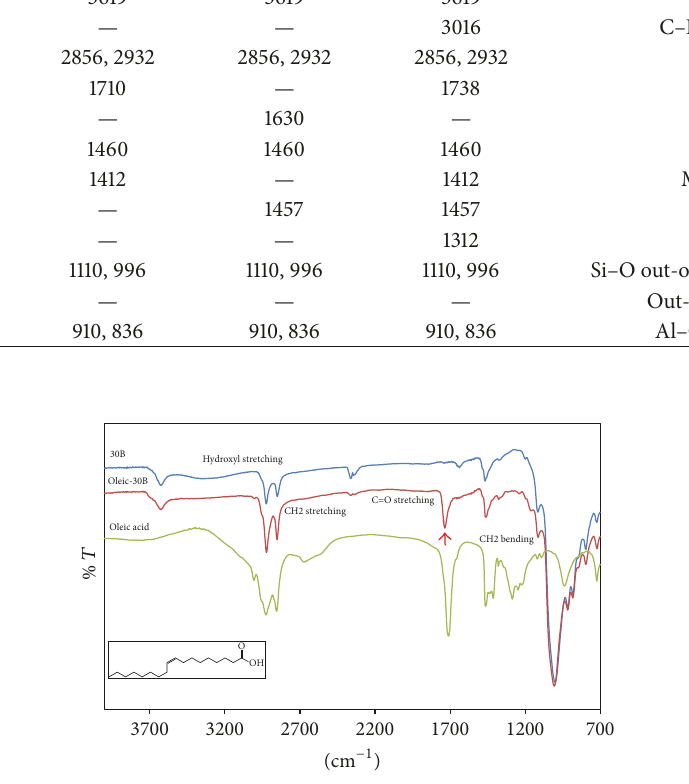
Figure 2: FTIR spectra of oleic acid, 30B, and modified clay (ol-30B).